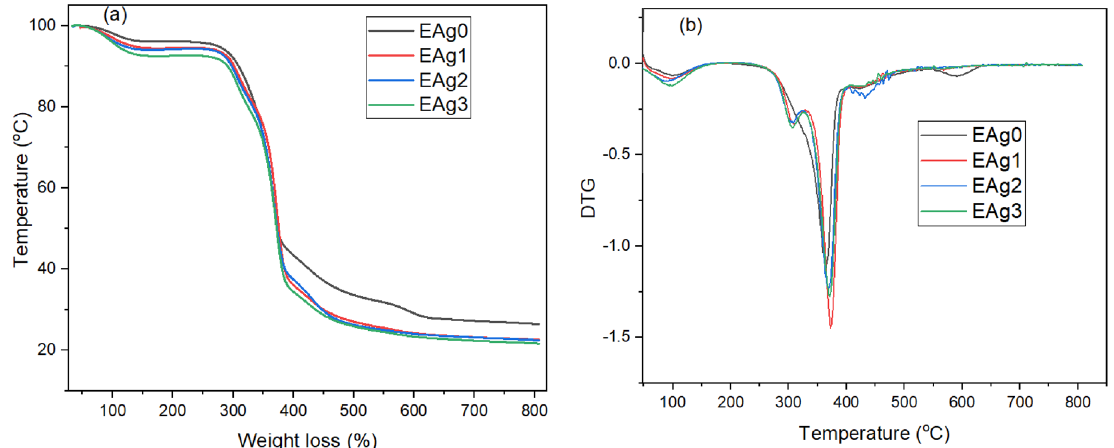
Figure 8. TGA and DTG analysis of control and nanosilver-coated sisal/cotton interwoven fabrics: ( a ) TGA and ( b )